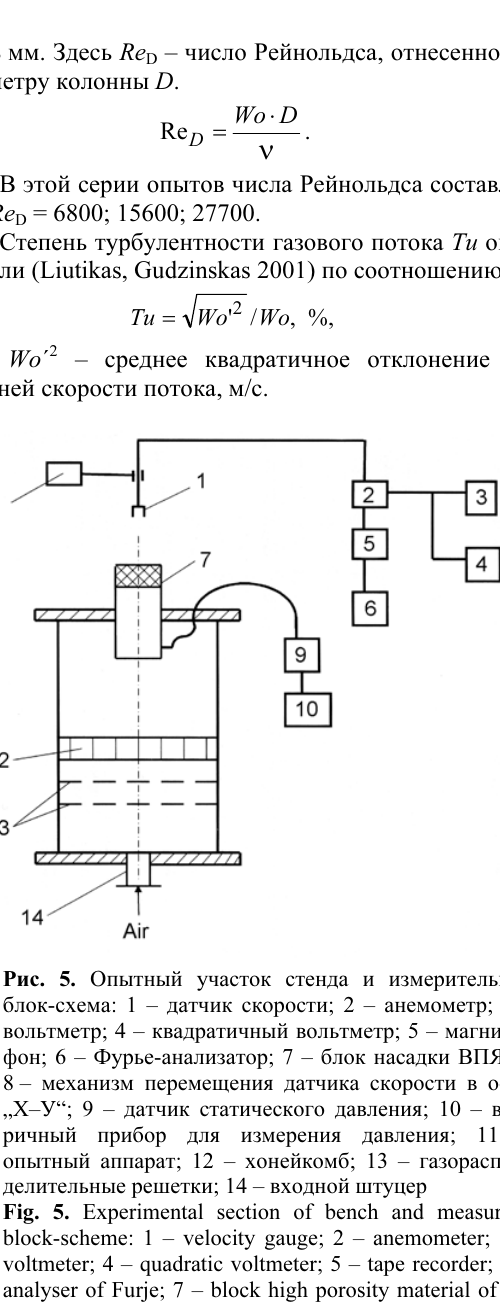
Fig. 5. Experimental section of bench and measuring